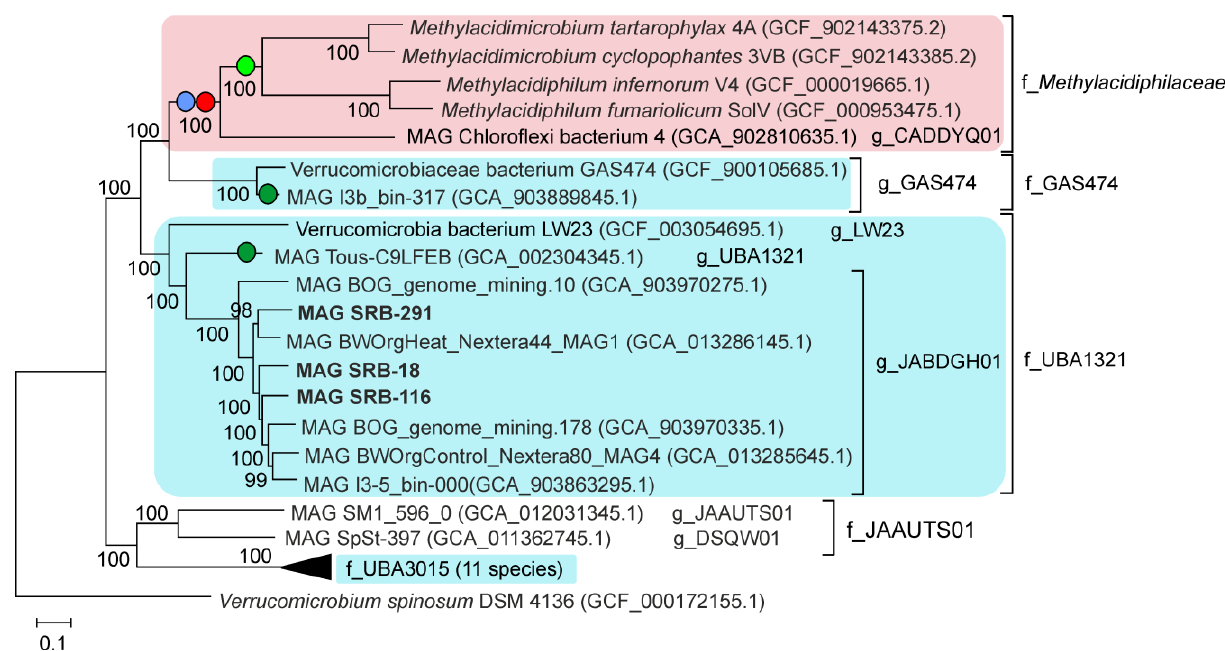
Figure 4. Genome-based phylogeny of the order Methylacidiphilales defined in the GTDB. Taxonomy is shown according to the GTDB (f_,family; g_, genus). The genome sequence of Verrucomicrobium spinosum DSM 4136 was used to root the tree. The presence of pmoCAB genes, the Calvin cycle and nitrogenase in particular lineages are indicated by red, blue and green circles, respectively. Light green and dark green circles indicate two different nitrogenase types. Lineages detected in geothermal habitats are marked in pink, while those from soil and aquatic environments are marked in blue.